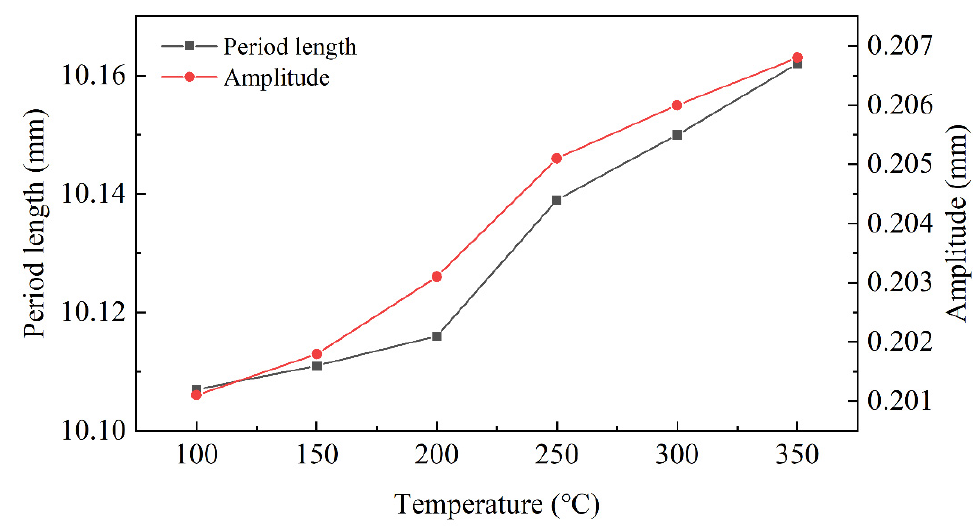
Figure 10. The morphology curve with different temperatures. The roll-speed-morphology profiles of interface are explored in Figure 11. The roll speed values of 1 rad/s, 1.5 rad/s, 2 rad/s, 2.5 rad/s and 3 rad/s were set, respectively, for the straightening simulation. The amplitude and period length both decreased along with roll speed. According to Equation (8), the increase in roll speed meant that the bending moment by roll decreased when other conditions remained unchanged. It was the reason that the reduction of amplitude was significantly greater than that of period length.